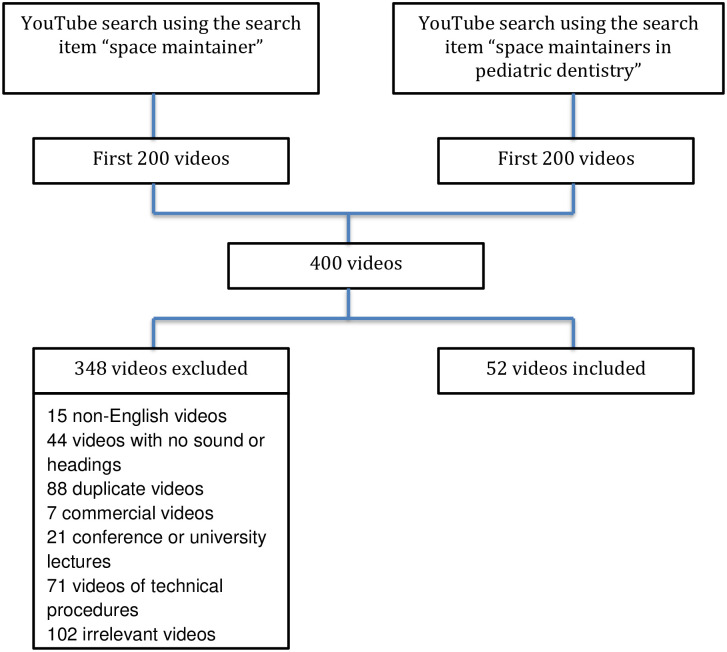
YouTube video selection for analysis.